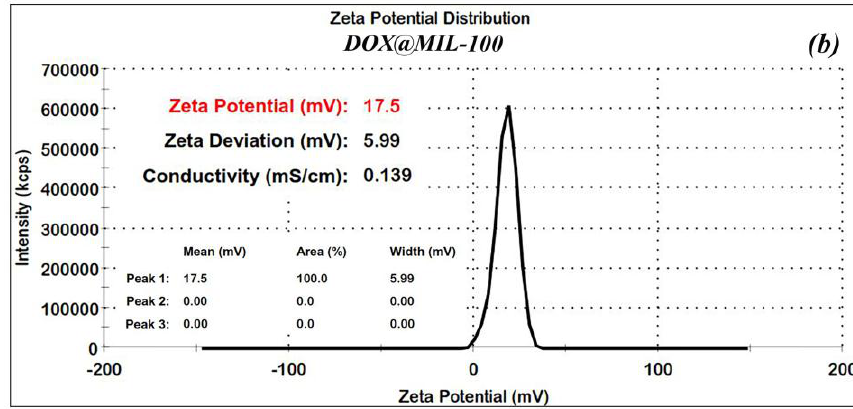
Figure 4. Zeta potential for nano-MIL-100 ( a ) and DOX@MIL-100 ( b ).